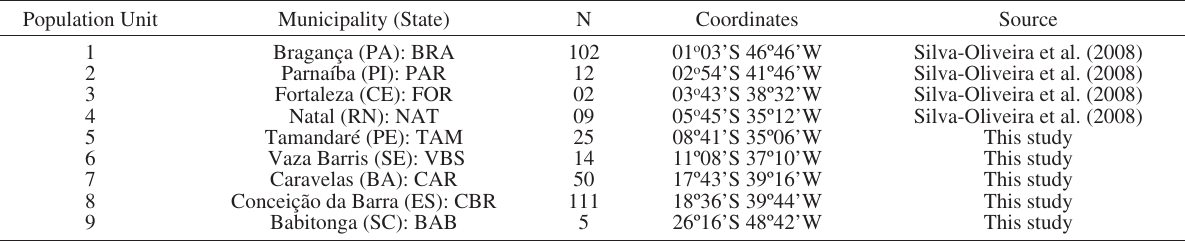
Table 1. – Number (N) of specimens of Epinephelus itajara from different locations in Brazil. Population